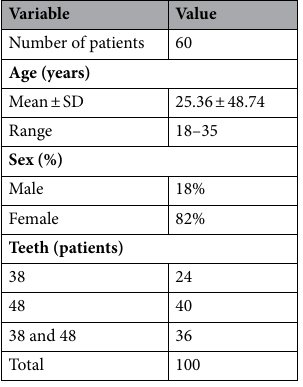
Table 1. Characteristics of the patients.